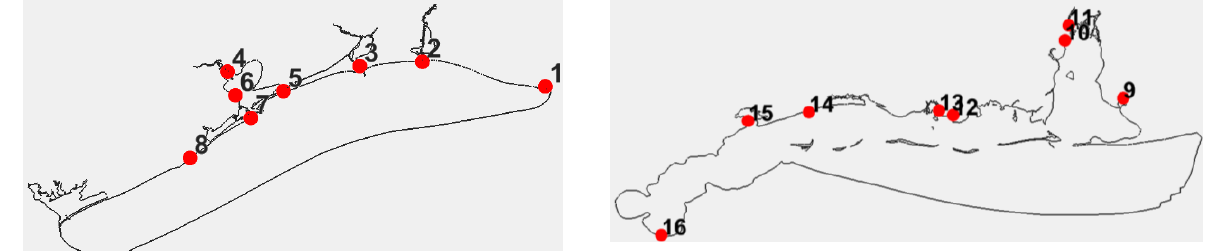
Figure 14. Station location maps for water level skill assessment comparison between nested NGOFS and NGOFS.